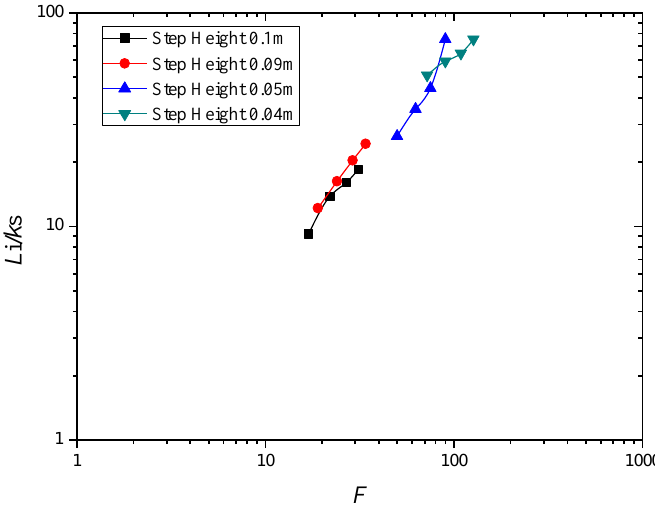
Figure 7. Normalized Li with respect to Froude surface roughness.